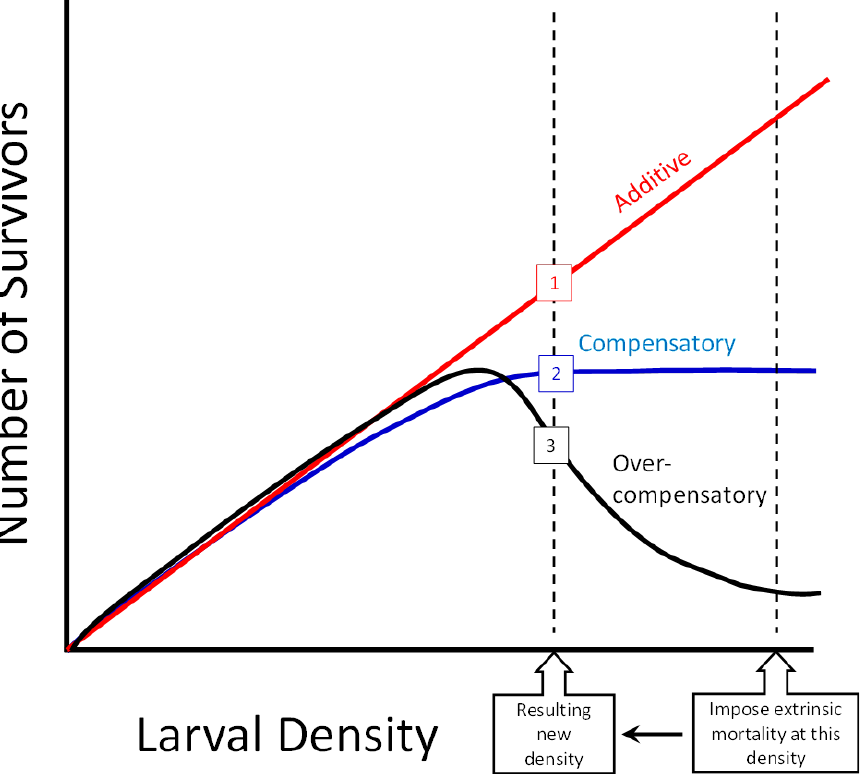
Figure 1. Three potential relationships between initial larval density and number of survivors, and the effect of imposing extrinsic mortality on a high-density population, reducing its density to a new, lower population density. Additive (red): imposing mortality would result in fewer survivors compared to not imposing mortality, as shown by point (1). Compensatory (blue): imposing mortality would result in the same number of survivors compared to not imposing mortality, as shown by point (2). Overcompensatory (black): imposing mortality would produce a greater number of survivors compared to not imposing mortality, as shown by point (3).